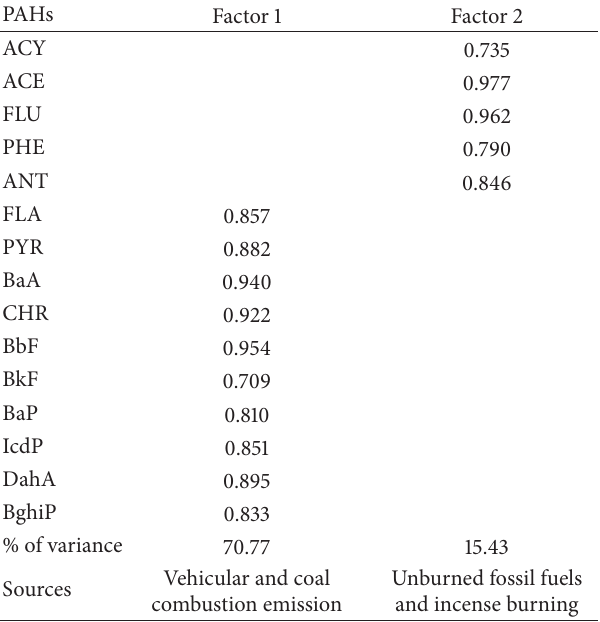
Table 5: Factor analysis for particulate-bound